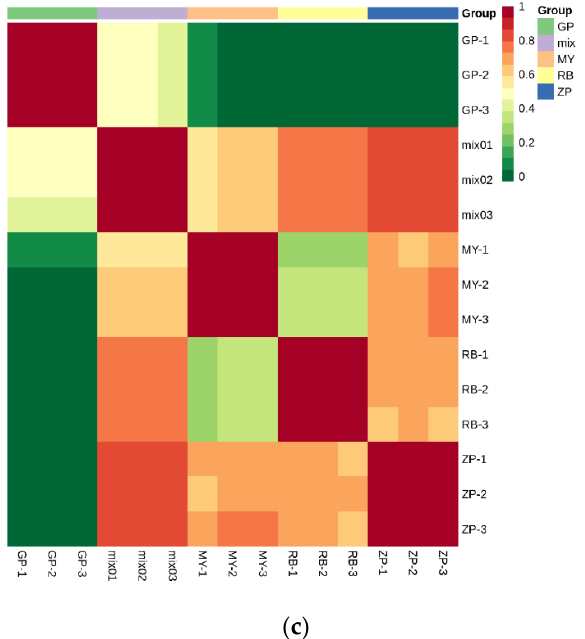
Figure 3. PCA score plots and correlation diagram between samples (RB, ZP, MY, GP) and quality control (QC) samples (mix). ( a ) PCA score plots; ( b ) PCA 3D score plots. Every point represents an independent biological replicate. ( c ) Correlation diagram between samples. The abscissa represents the sample name, the ordinate represents the corresponding sample name, and the color represents the value of the correlation coefficient.